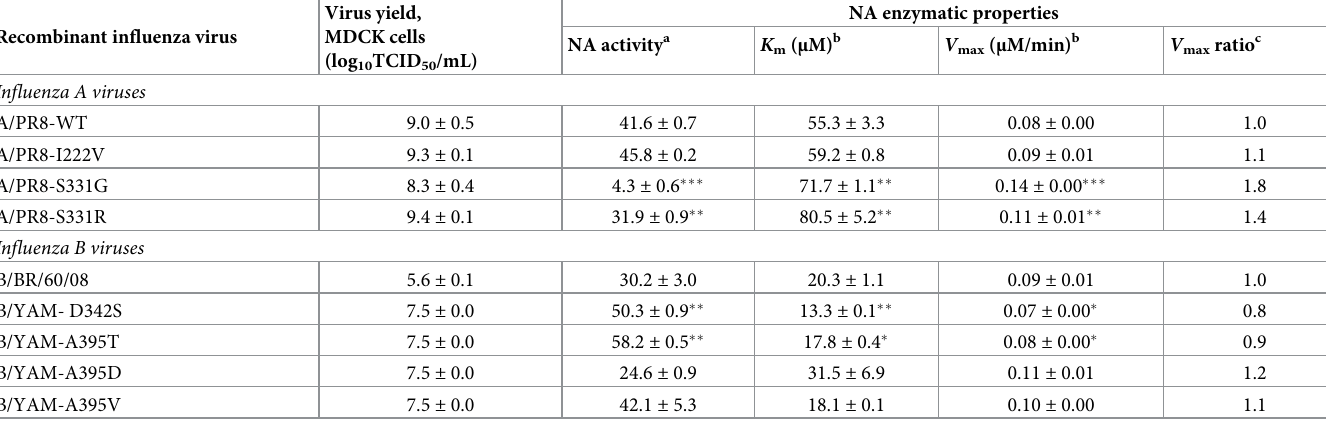
Table 3. NA activity and NA enzyme kinetics of recombinant influenza A and B